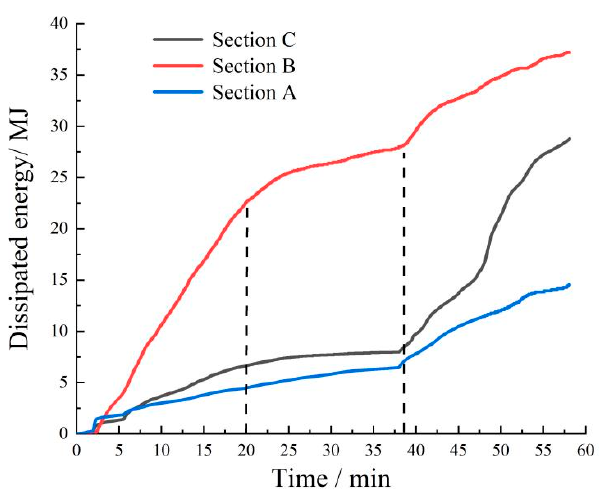
Figure 18. Comparison of Energy Dissipation in the three studied sections.